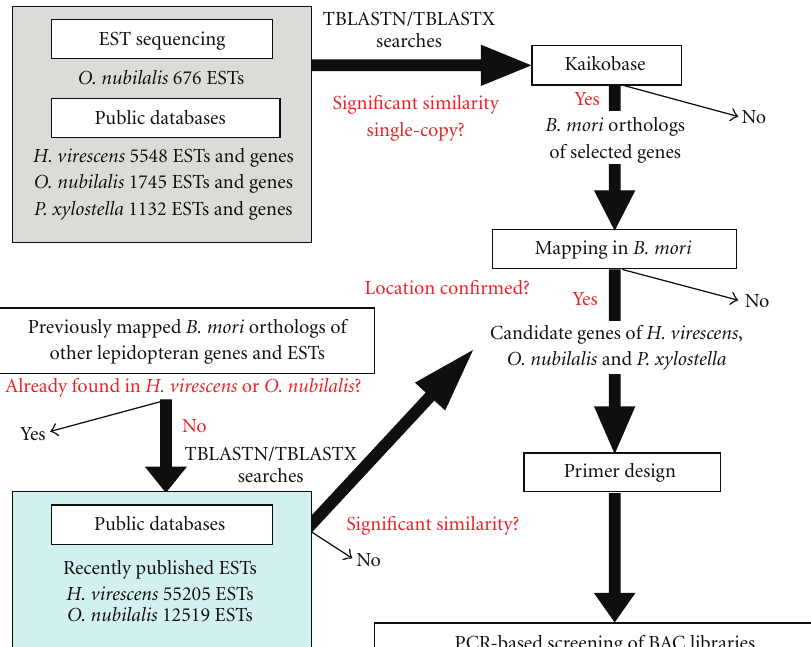
Figure 2: Strategy for selection of genes and ESTs in this experiment. Known genes and ESTs [13, 16, 25] were used as queries against a B. mori genome database, Kaikobase [20]. ESTs published later [14, 15, 17] were searched when no candidates were found in the first